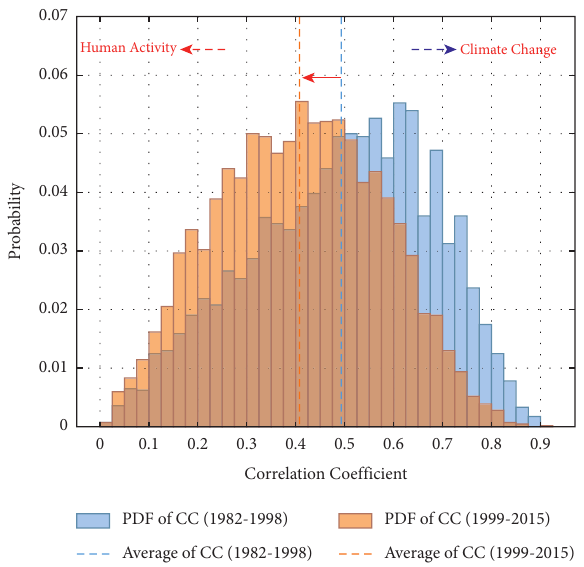
Figure 6: Probability density functions of correlation coefficients using MLR in the two